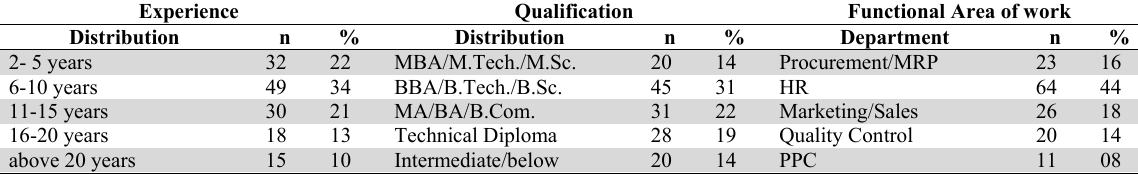
Demographic distribution of respondents (N = 144)